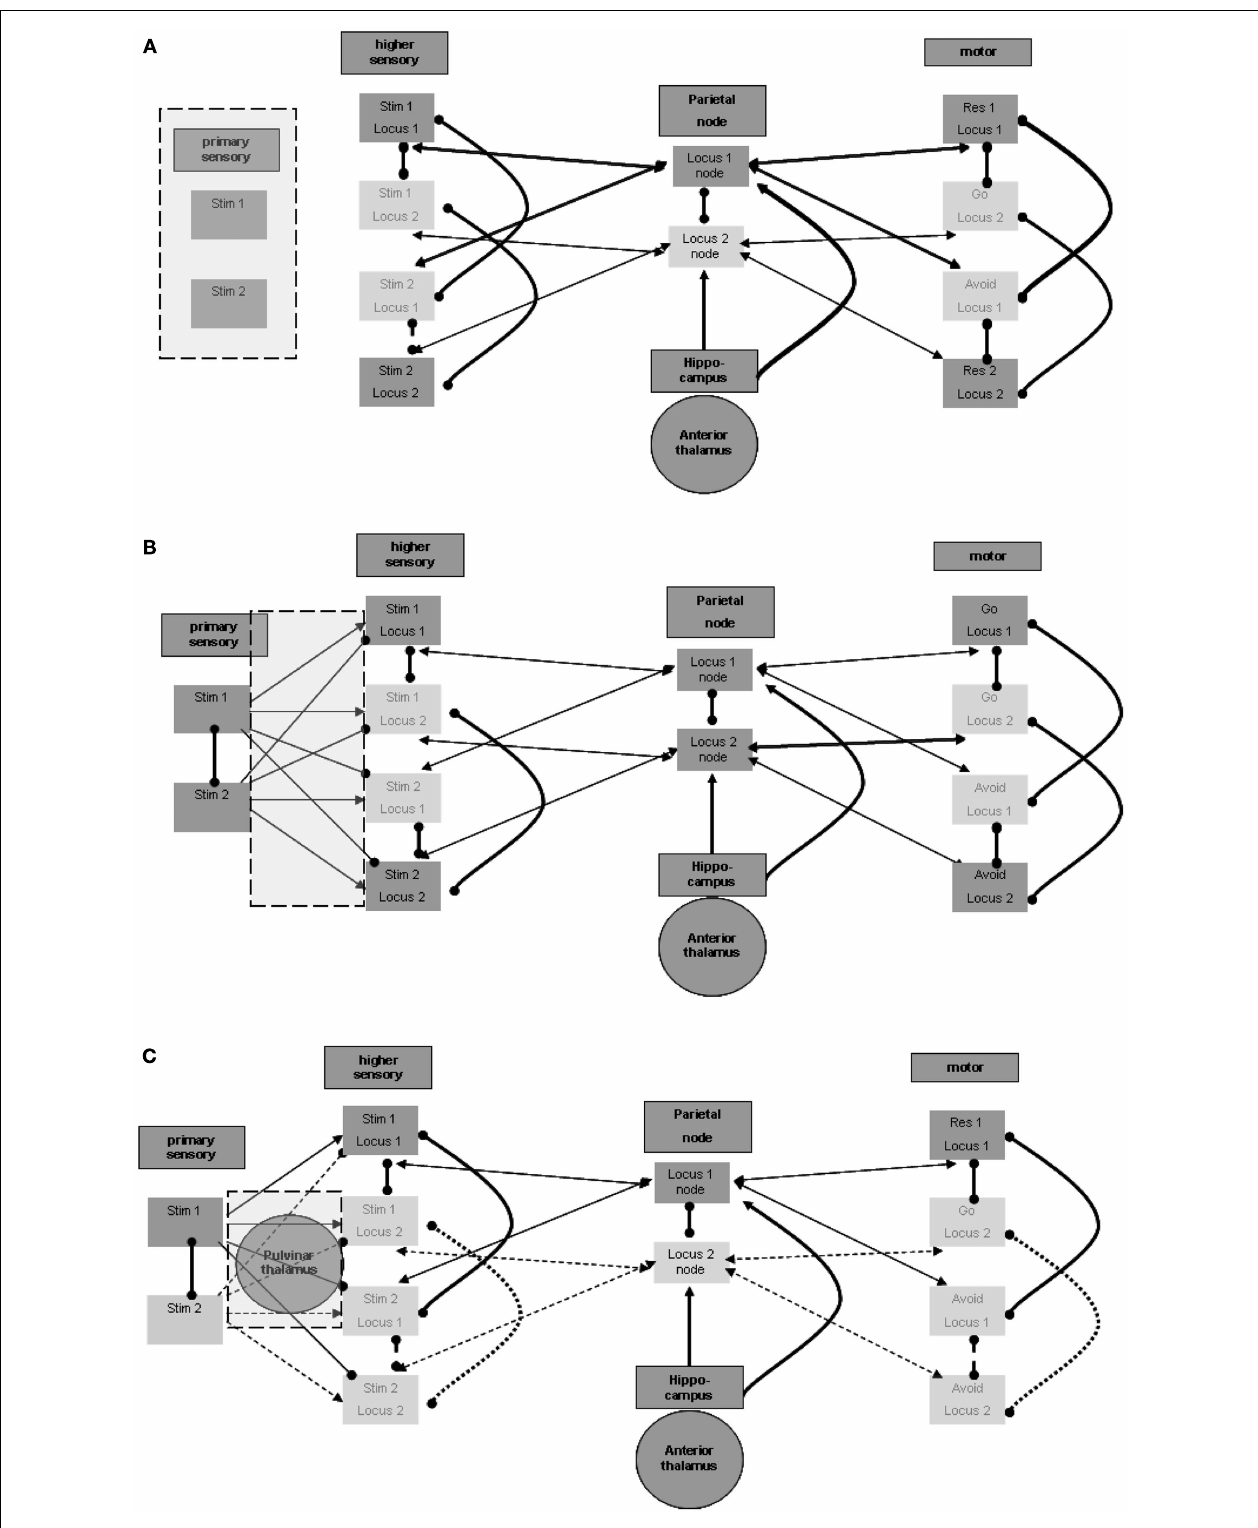
FIGURE 3 | Perception process . (A) Distinction between primary and higher sensory regions and units. (B) Excitation and inhibition from primary to higher sensory regions. (C) Possible thalamic involvement in perception.